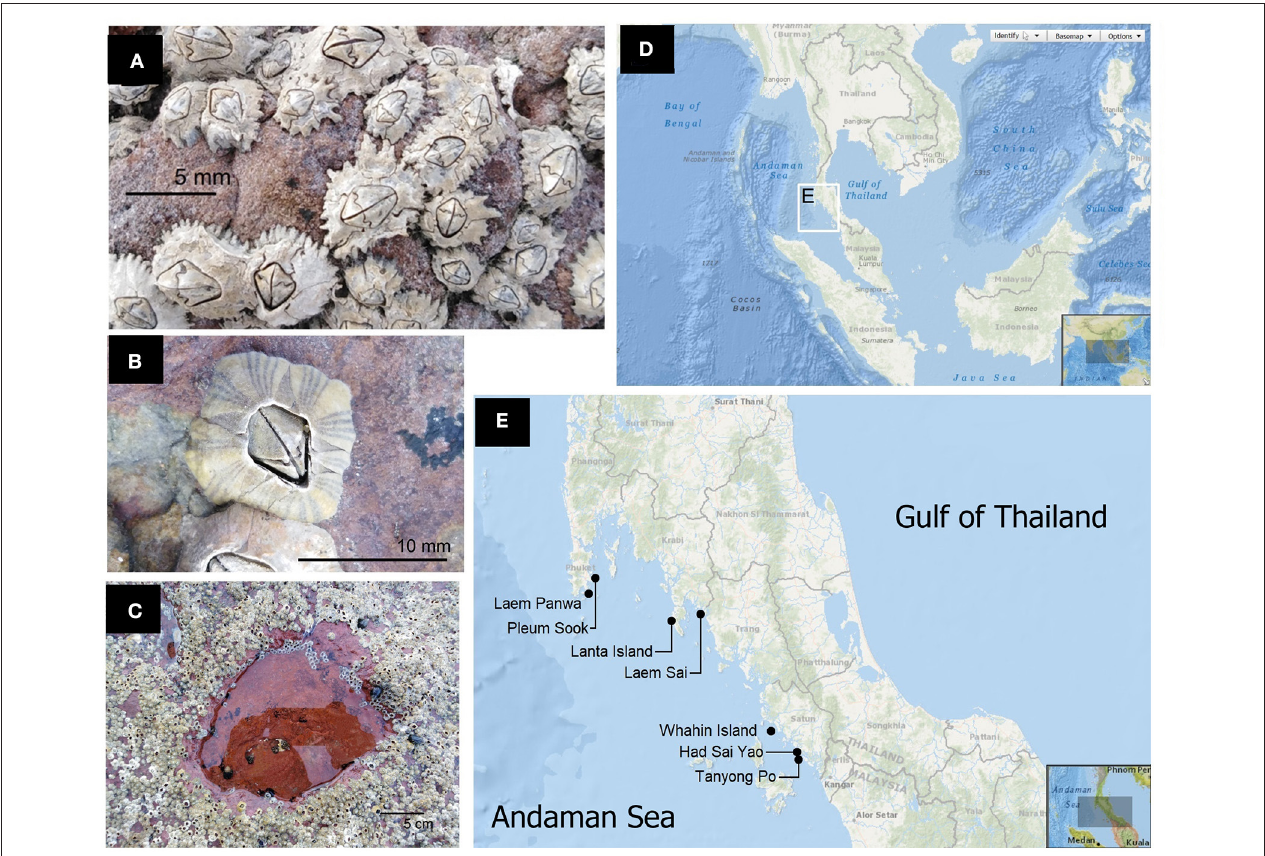
FIGURE 1 | (A) Chthamalus malayensis is a common barnacle on mid shores of the Andaman rocky shores. (B) Amphibalanus amphitrite are common on low shores of the Andaman intertidal zone. (C) On the Andaman Coast of Thailand, barnacles are common on open rock surfaces adjacent to rock pools, but relatively rare inside pools. (D) Study region on the Andaman coast of Thailand, magnified in (E) . (E) Seven study shores spanning from the northern to southern coasts on the Andaman coast of Thailand. (D,E) Courtesy of NOAA Bathymetric Data